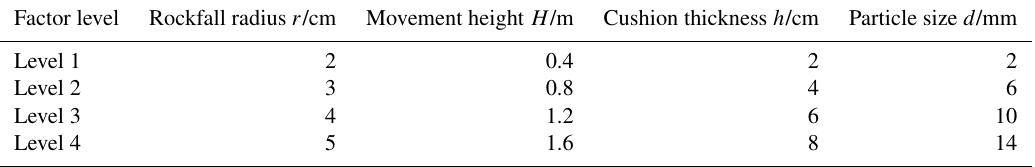
Table 4. Factors and levels for the orthogonal